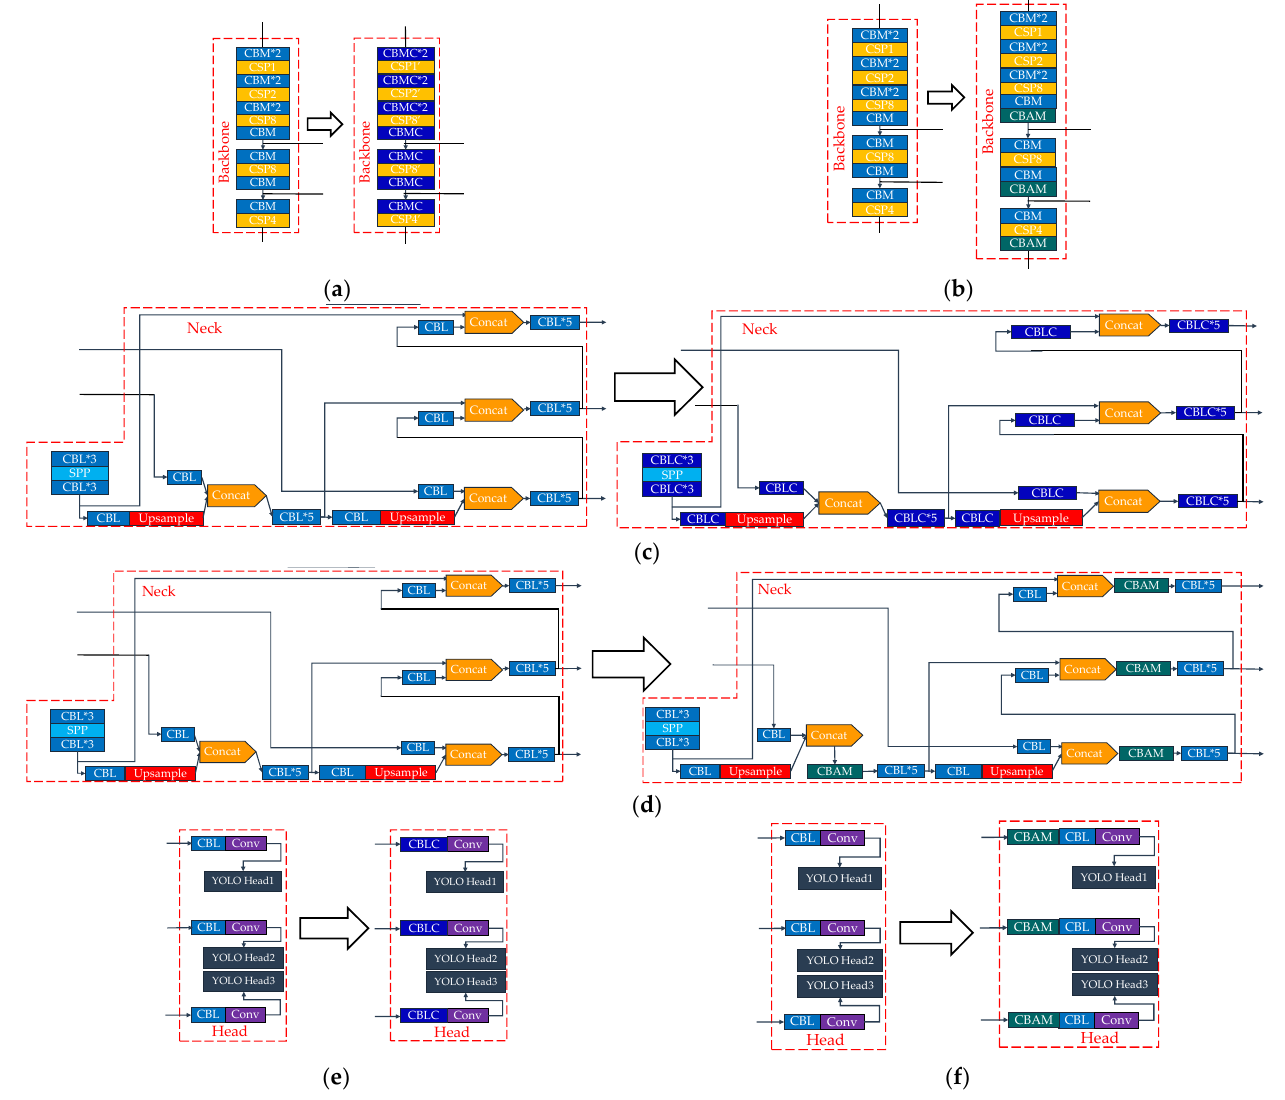
Figure 7. Adding CBAM modules in the Backbone, Neck, and Head regions. ( a ) YOLOv4B1. ( b ) YOLOv4B2. ( c ) YOLOv4N1. ( d ) YOLOv4N2. ( e ) YOLOv4H1. ( f ) YOLOv4H2.